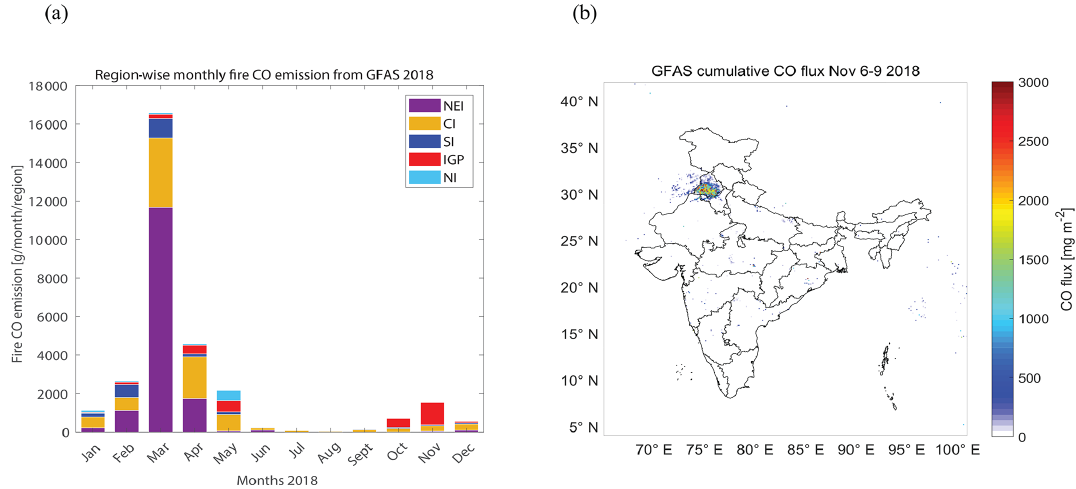
Figure 2. (a) The monthly integrated GFAS fire CO emissions (mg/m 2 per month) over different regions of India (as seen in Fig. 1) during the year of 2018. (b) Integrated GFAS fire CO emission during 6–9 November